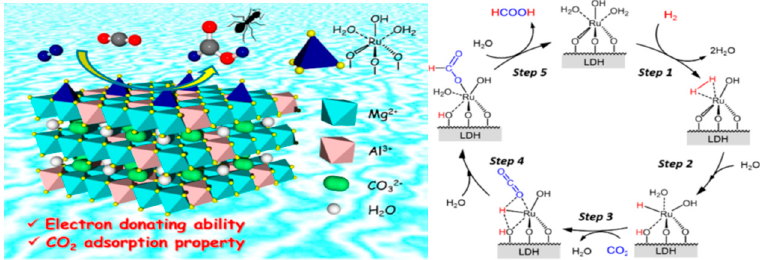
Figure 3. Ru/LDH SAC catalyzed CO 2 hydrogenation to formic acid. Reprinted with permission from Ref [50] . Copyright 2017, American Chemical Society.